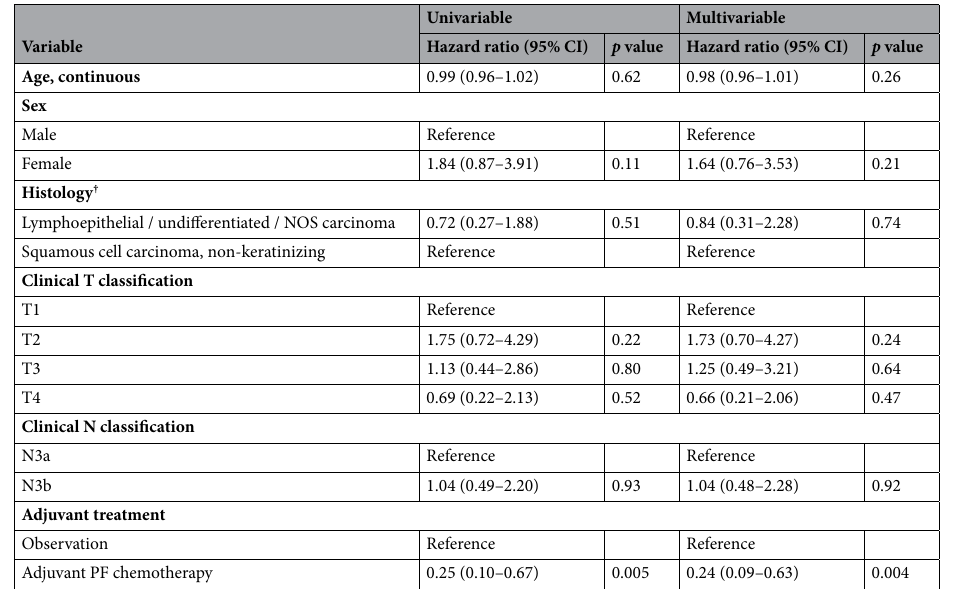
Table 3. Univariable and multivariable Cox proportional hazards model for disease-free survival (n = 310). CI, confidence interval; NOS, not otherwise specified. † There were no events for the Squamous cell carcinoma, keratinizing or NOS